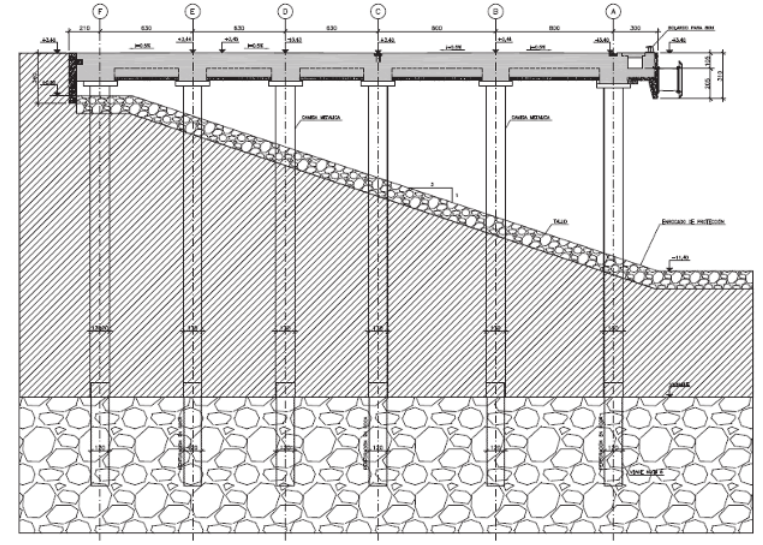
Design response spectra with return period TR of 475 years and ξ =